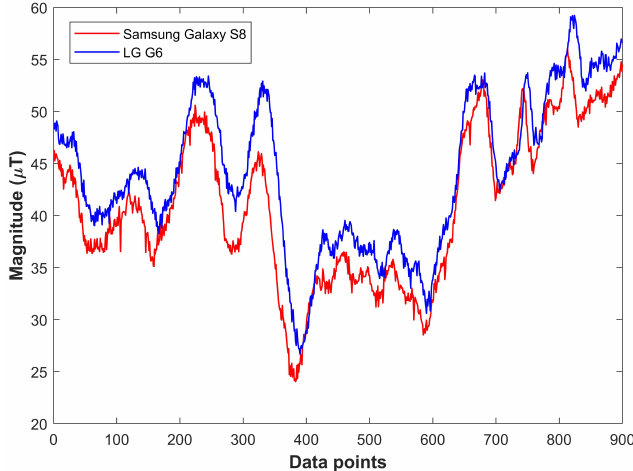
Figure 2. Magnetic intensity values with various smartphones for same location at same